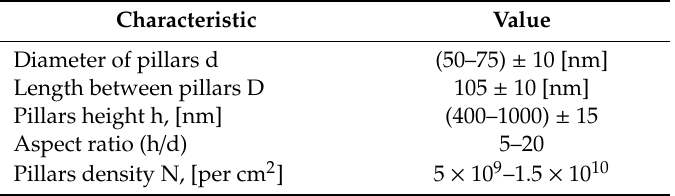
Table 1. Topological characteristics of NiNPs. Table 1 . Topological characteristics of NiNPs.